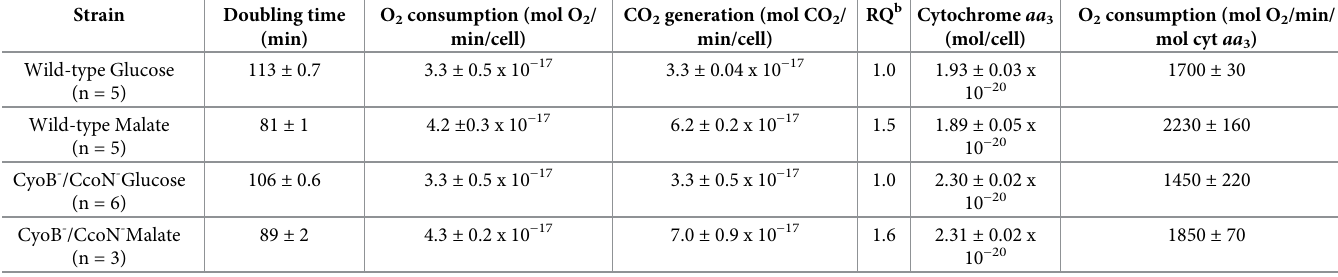
Table 1. Metabolic parameters of P . denitrificans strains grown in glucose or malate a .